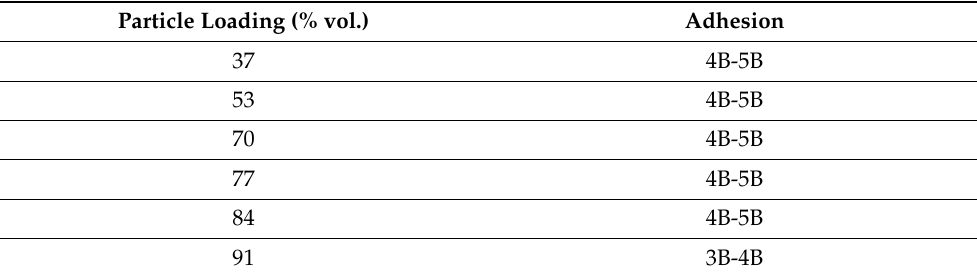
Table 6. Adhesion level of the coatings by tape test. Particle Loading (%